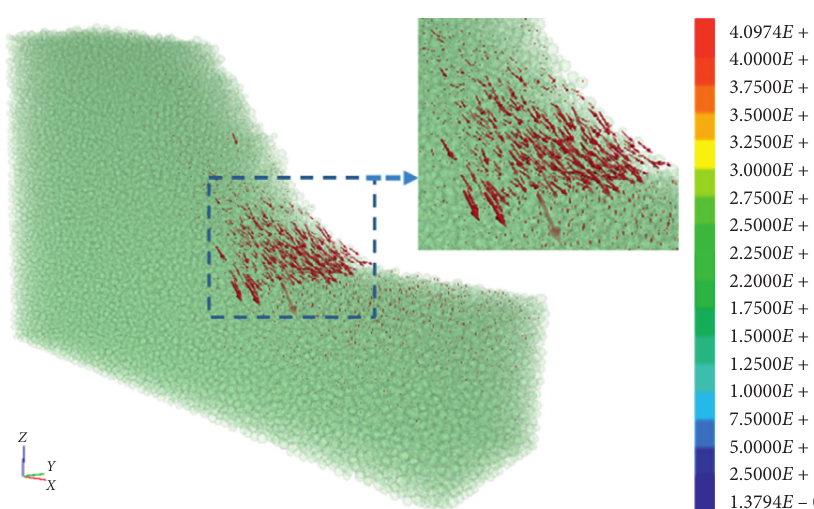
Figure 21: Displacement vector